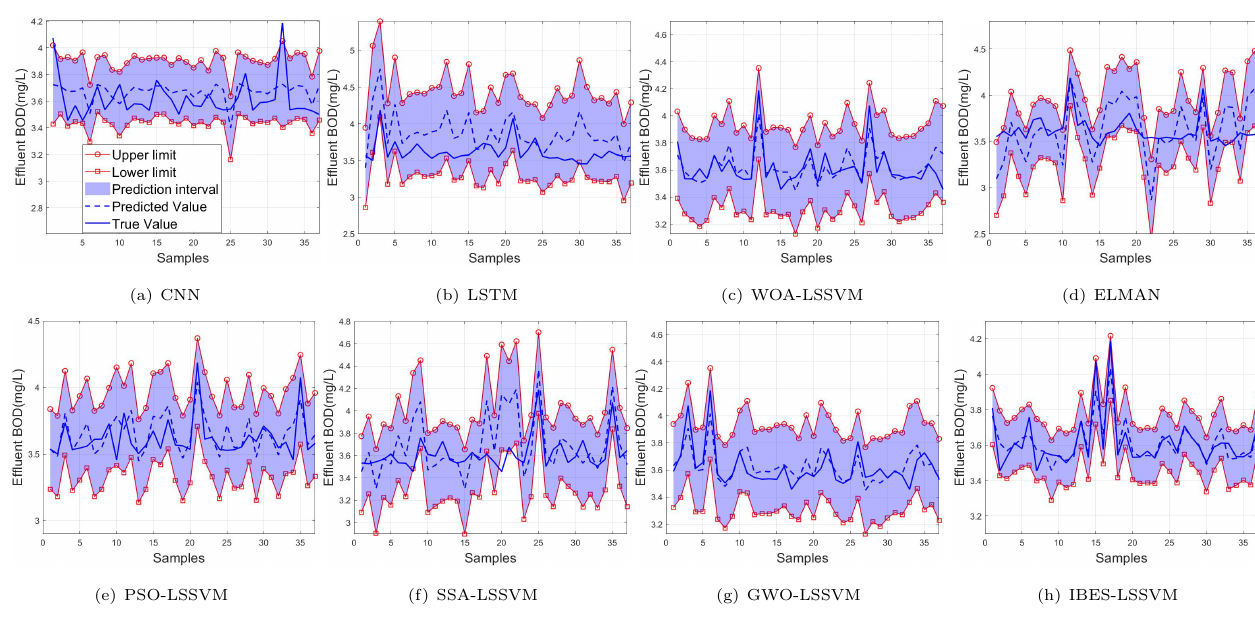
Figure 17. 95% of NH3-N.